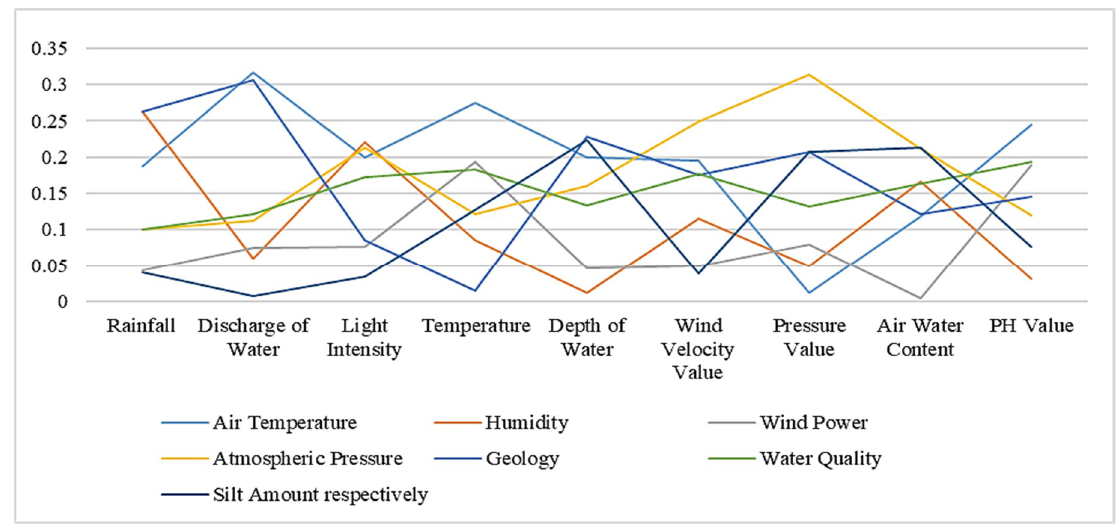
Figure 3. Similarity results based on semantic strategy.